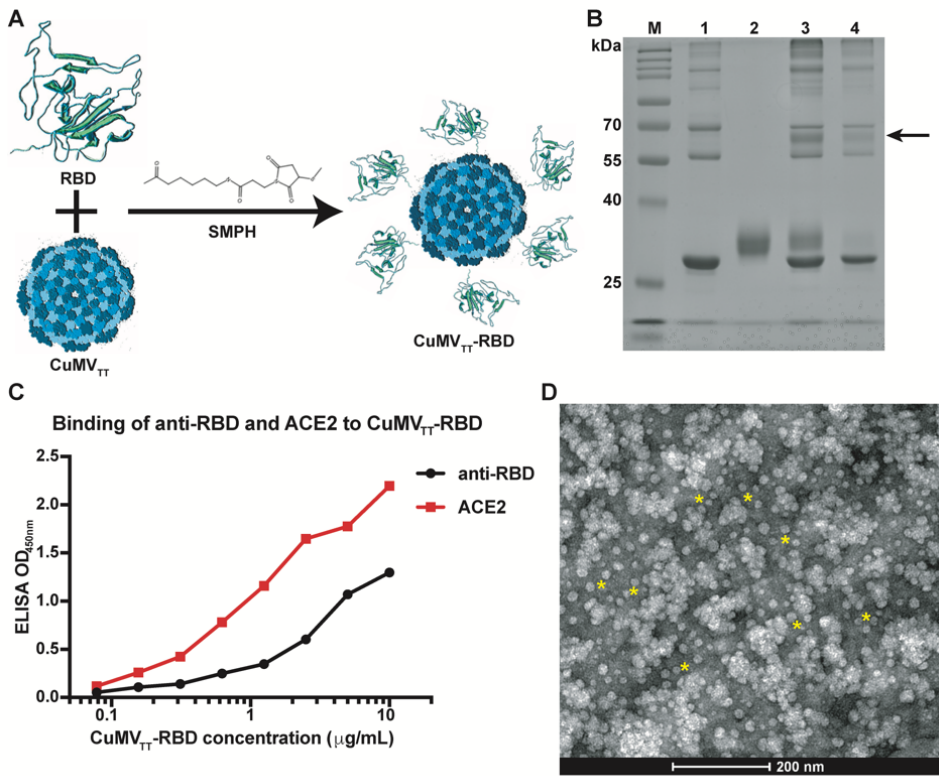
Figure 1. Coupling of spike–RBD with CuMV TT viruslike particle (VLP). ( A ) Outline of the strategy to display RBD on CuMV TT surface. ( B ) Analysis of the RBD and coupling reactions of the RBD to CuMV TT by SDS-PAGE. Coupling band is indicated by an arrow. Lane 1: CuMV TT linked to SMPH; lane 2: RBD; lane 3: coupled CuMV TT –RBD with free RBD; lane 4: coupled CuMV TT –RBD without free RBD. An amount of 5 µ g of each sample was loaded. ( C ) Binding of the CuMV TT –RBD vaccine to the anti-RBD antibody and human ACE2 by ELISA. An amount of 5 µ g of the anti-CuMV TT antibody was coated to capture different concentrations of the CuMV TT –RBD vaccine. ( D ) Transmission electron microscope (TEM) image of the coupled CuMV TT –RBD vaccine. Yellow stars indicate the CuMV TT –RBD VLP.